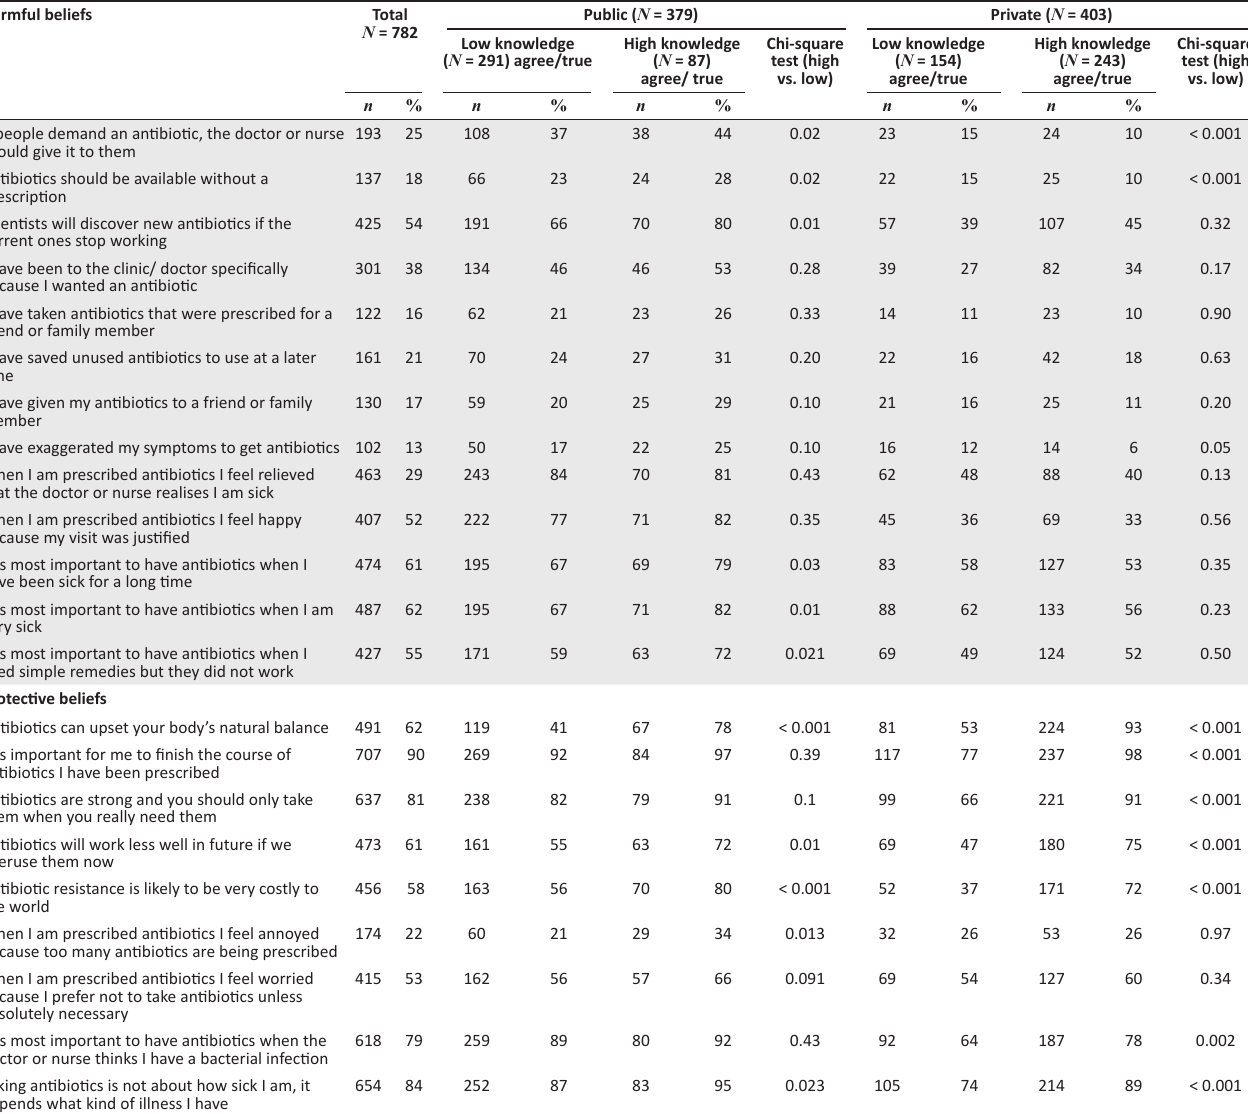
TABLE 3: Beliefs and behaviours between low and high knowledge scorers in both the public and private sector Harmful